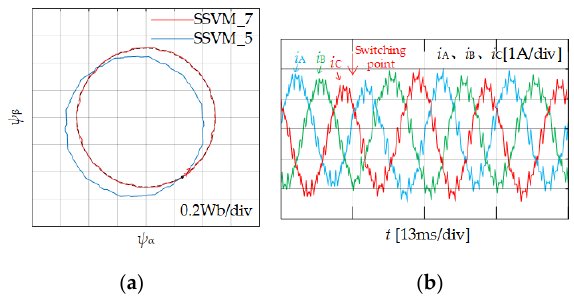
Figure 4. Stator flux trajectories and current change during switching. ( a ) Stator flux trajectories change. ( b ) Current change.